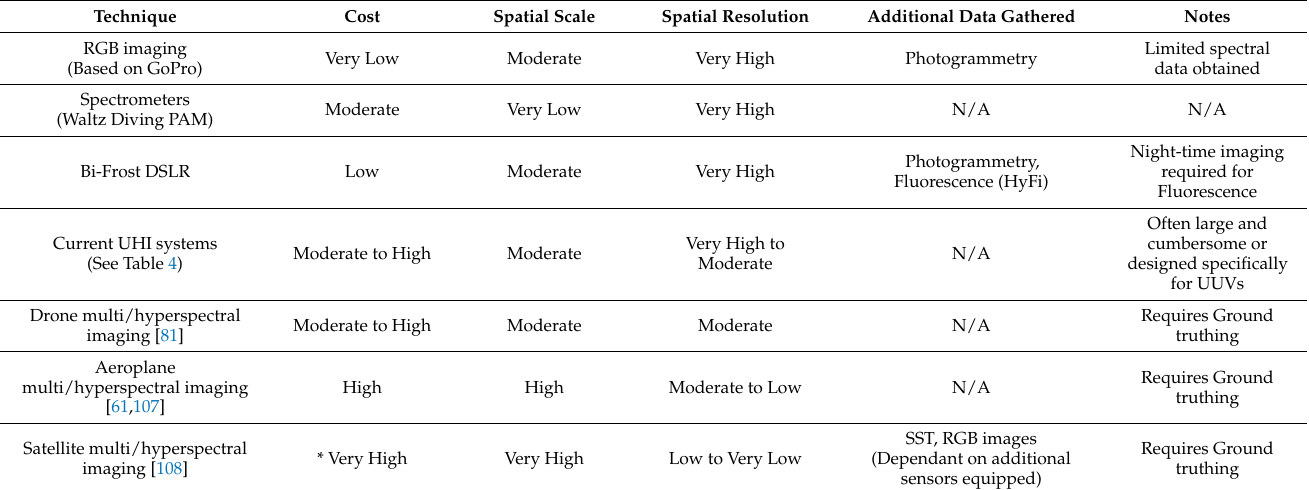
Table 2. Optical techniques rated by cost, spatial scale, spatial resolution, and additional data gathered.